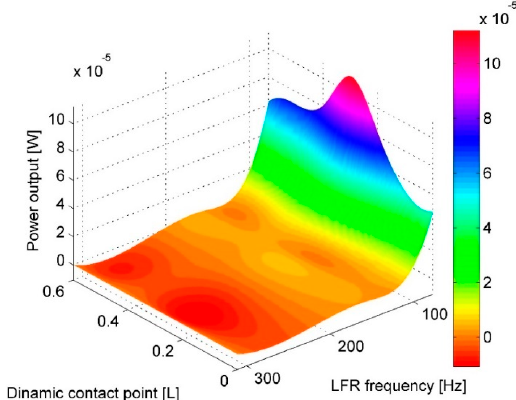
Figure 6. RMS power output of different tandem configurations and contact points with optimal resistive load R L .